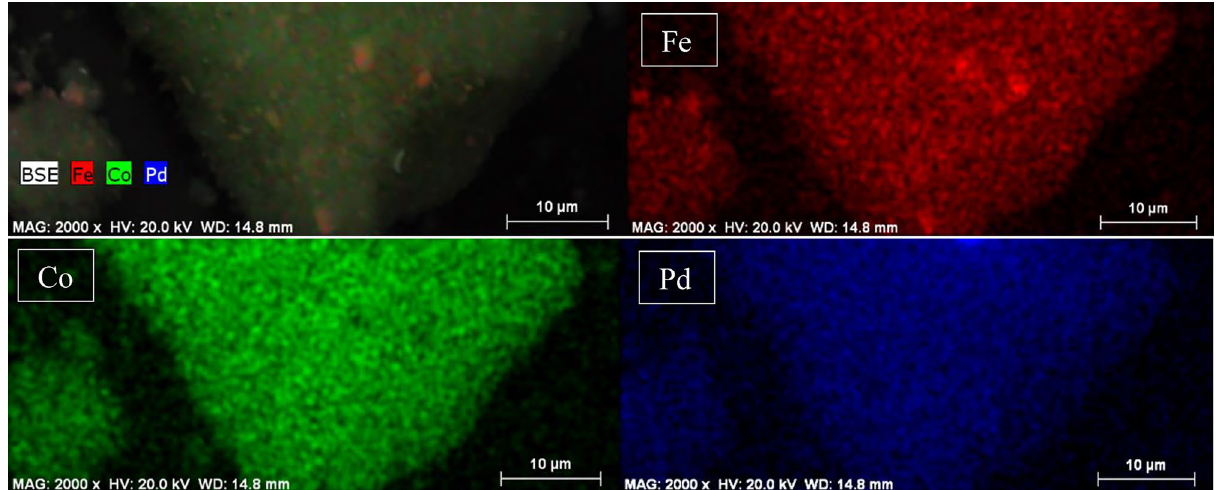
Figure 7. EDS elemental mapping images of the γ-Fe 2 O 3 @MBD/Pd-Co.